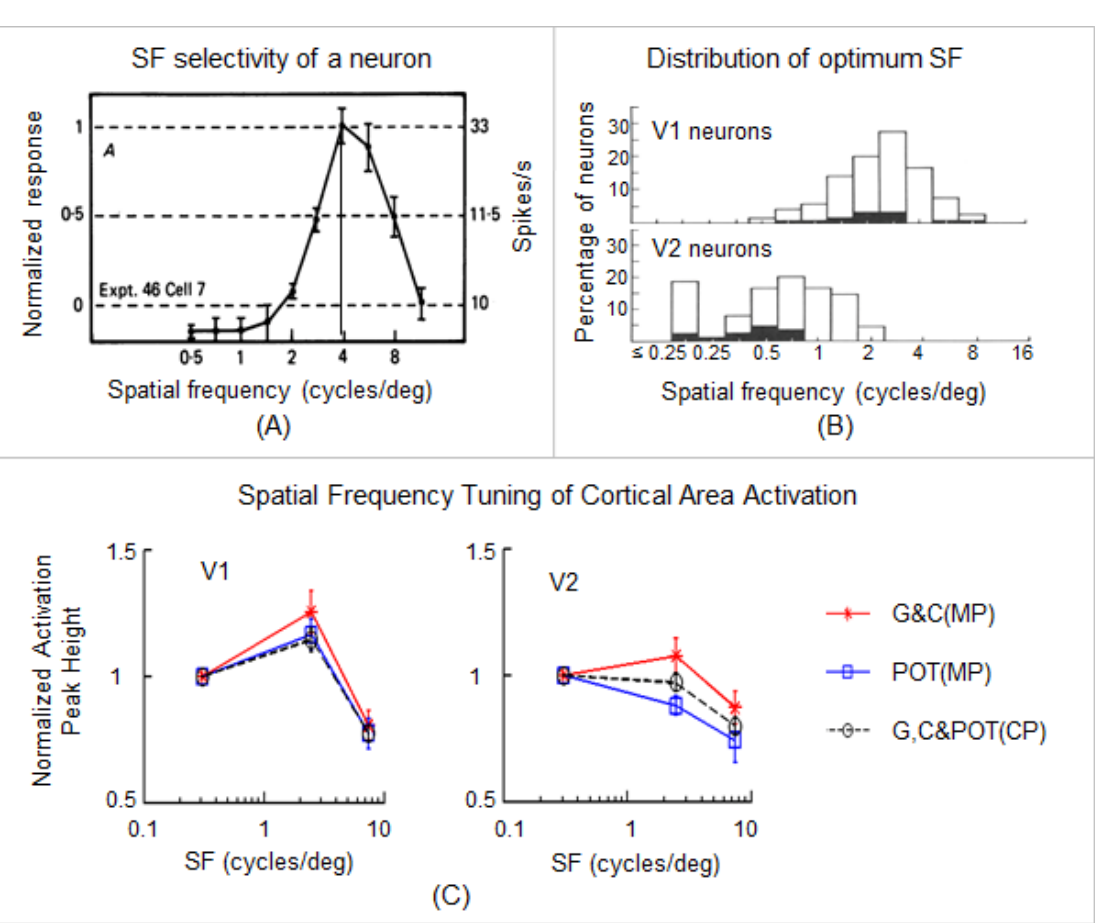
Figure 2. The effects of the colored lenses on the SF-tuned BOLD response in area V1 and V2. ( A ): A representative SF tuning curve shows a band-pass response with an optimum SF (the vertical line). The majority of curves for macaque neurons in V1 (91%) and V2 (100%) are similar to this curve. ( B ): The distribution of optimum SF for V1 (top) and V2 (bottom) neurons. The difference between the means of the distributions (V1 = 2.2 cycles/deg; V2 = 0.65 cycles/deg) is statistically significant ( p < 0.001). The overlap between the two distributions is principally in the 0.7–2 cycles/deg range. ( A , B ) are reproduced with permission from [53]. ( C ): SF-tuned cortical area activation in V1 and V2. The dashed lines represent the mean peak heights of cortical area activation with the three lenses for the control participants (CP). The red solid lines represent the mean peak heights of cortical area activation with the G and C lenses for the migraine patients (MP). The blue solid lines represent the peak heights of cortical area activation with the POT lenses for the MP. Error bars indicate the standard errors of the means. ( C ) is reproduced with permission from [14]. (For further details, refer to [14]).